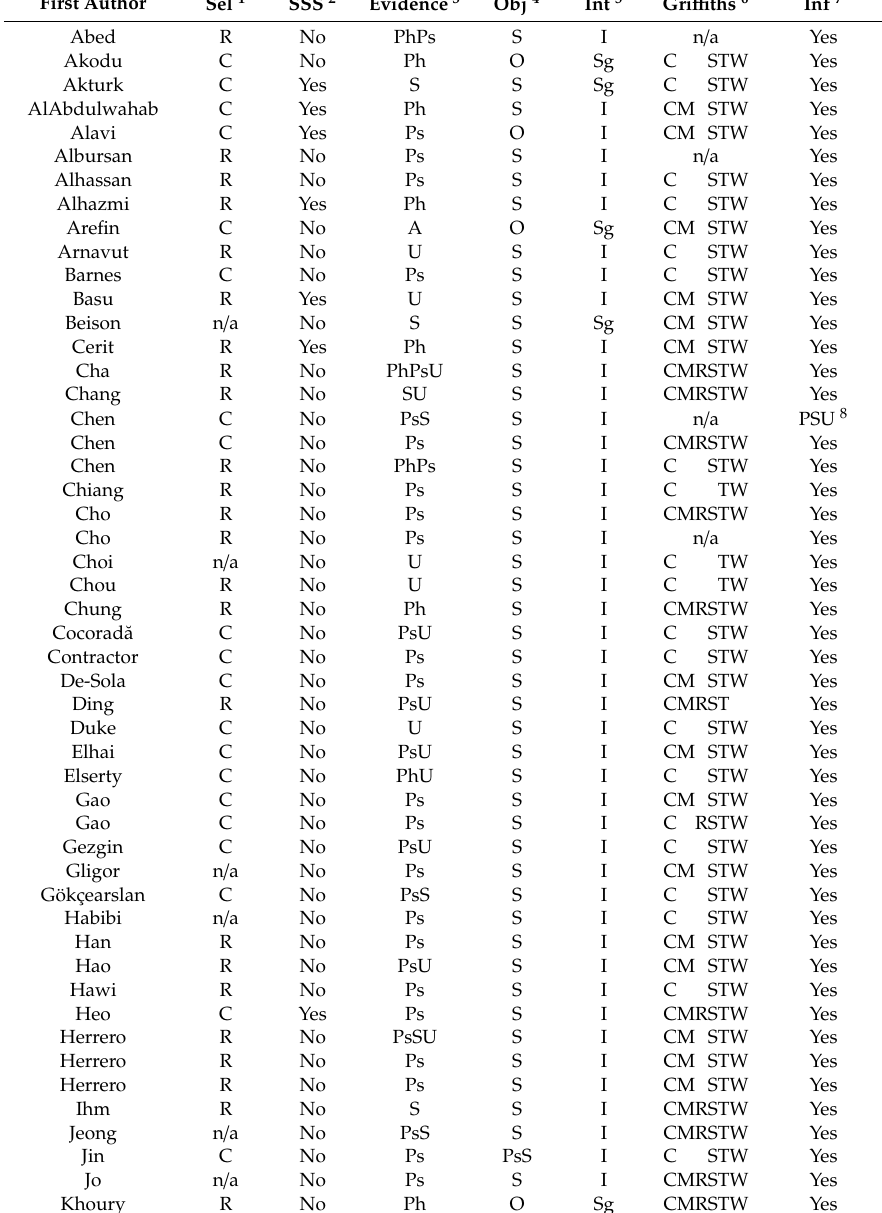
Table 5. The quality of samples, level of evidence, and theoretical framework of the